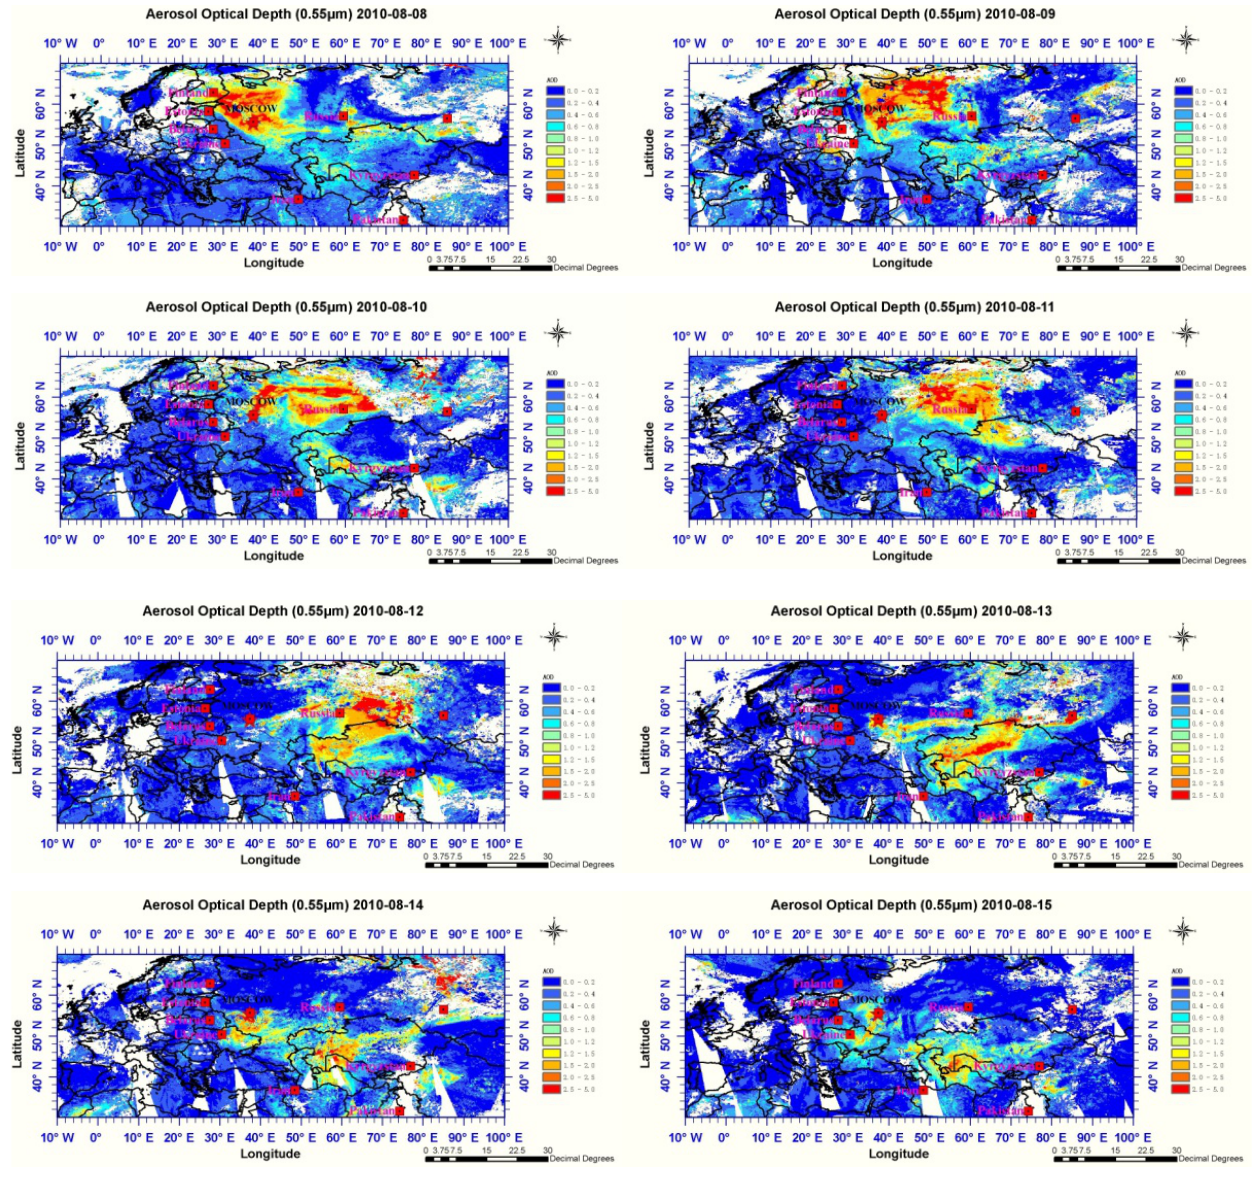
Figure4. AOD (at 0.55 μ m) distribution over the study area for the period from 31July to 15August 2010. The AOD was obtained from integration of the AOD retrieved from three different methods as described in the